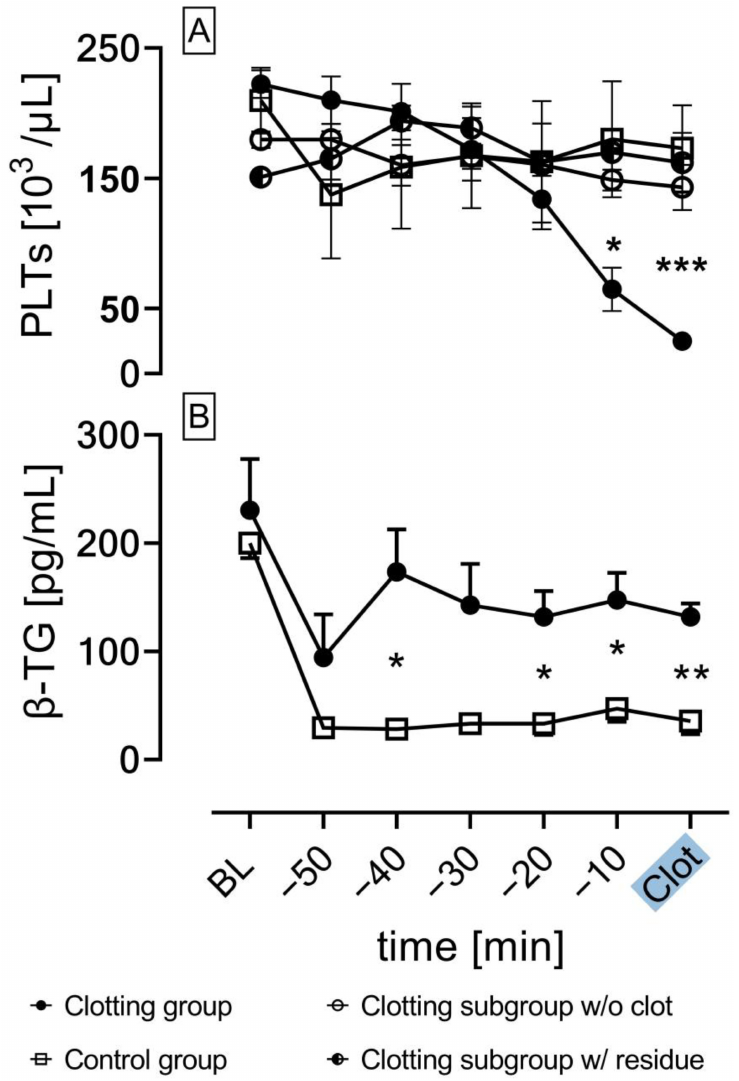
Figure 8. ( A ): Platelet count (PLTs) over time in the clotting group (0.5 IU/mL; n = 12), control group (1 IU/mL; n = 3), clotting subgroup w/o clot formation (0.5 IU/mL; n = 13) and the clotting subgroup w/residues (0.5 IU/mL; n = 2); significant decrease in the number of platelets in the clotting group with fulminant clot formation; ( B ): β -thromboglobulin concentration ( β -TG) over time in the clotting group with fulminant clot formation ( n = 12) and control group ( n = 3); ANOVA; mean ± SEM; * p < 0.05; ** p < 0.01; *** p <